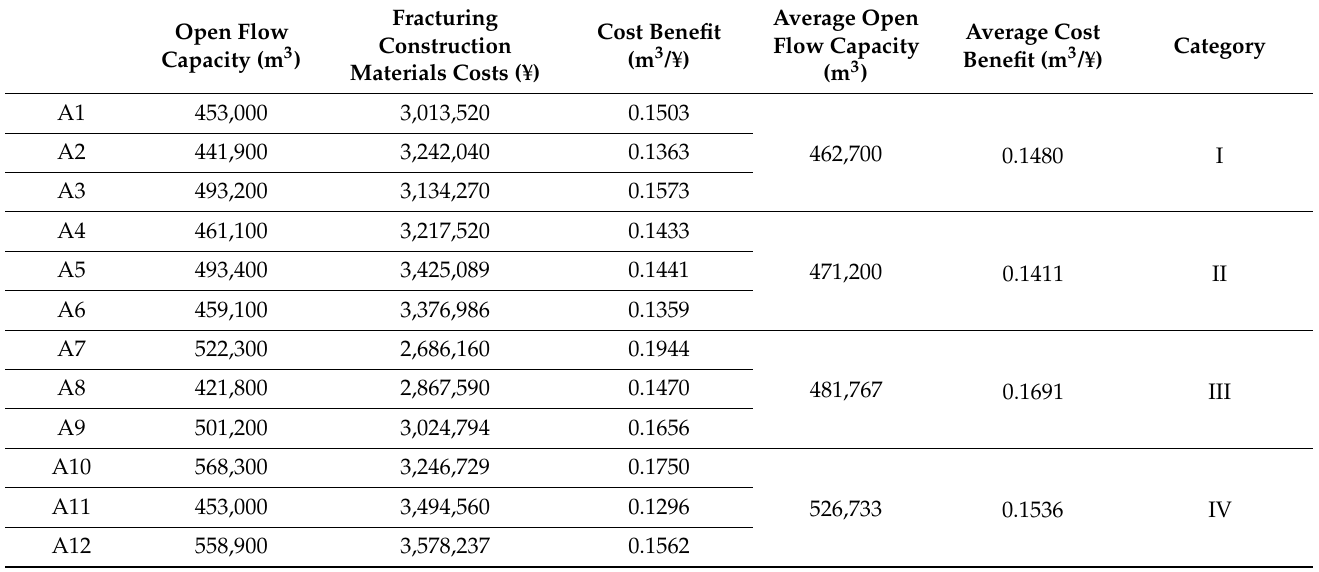
Table 6. Evaluation of the effectiveness of horizontal wells under different fracturing construction combination modes. Open